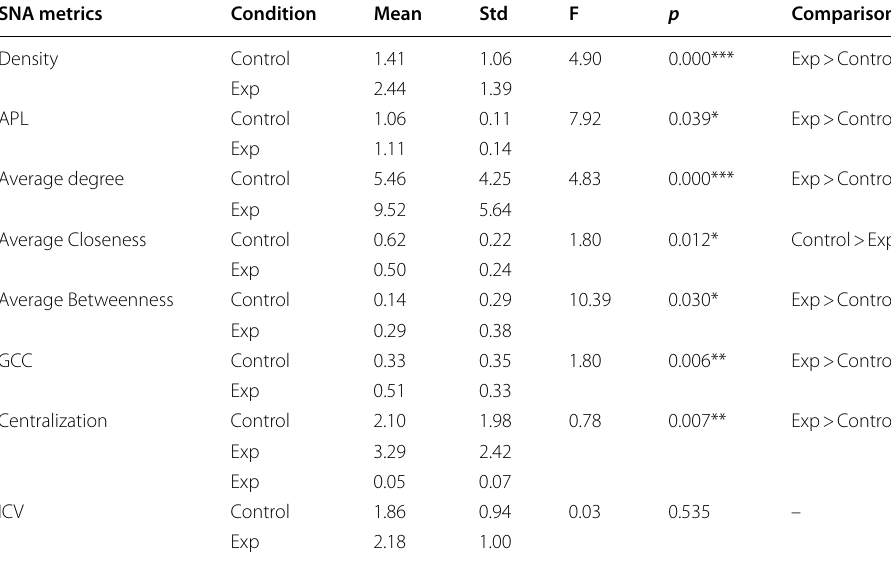
Table 3 The comparison of social engagement between two